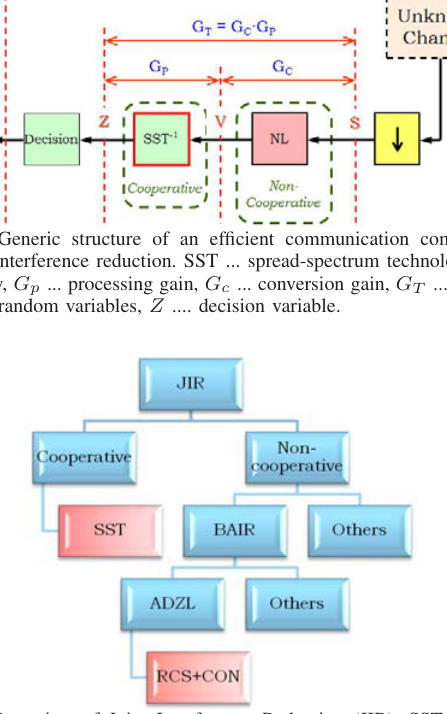
Fig. 3. Overwiew of Joint Interference Reduction (JIR). SST ... spread- spectrum technology, BAIR ... blind adaptive interference reduction, ADZL ... adaptive dead-zone limiter, RCS ... reliable chip-selector, CON ... threshold control.